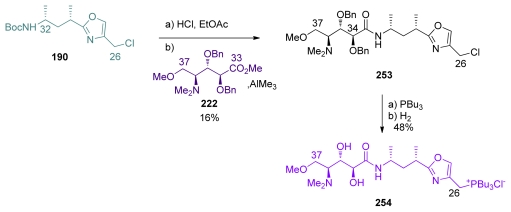
Preparation of C26–C37 fragment 254.